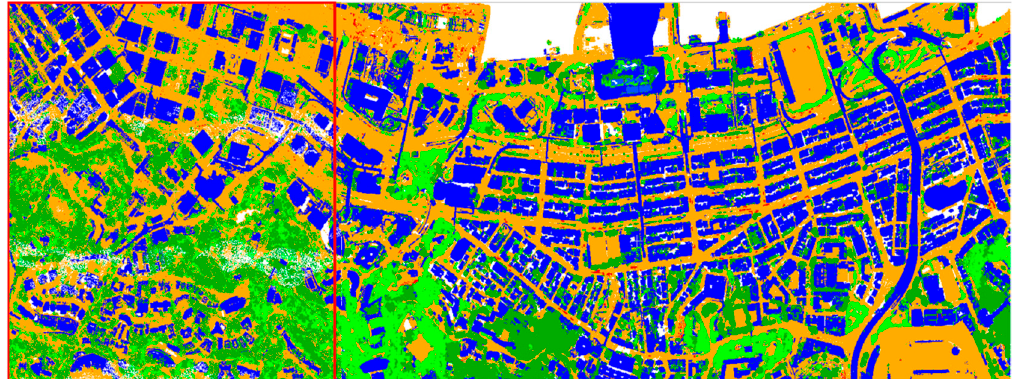
Figure 11. The training dataset and the semantic labeling results in 2D. The training dataset with manual labels is in the red square. The region outside the square comprises the semantic labeling results with labels as predicted by the proposed method.